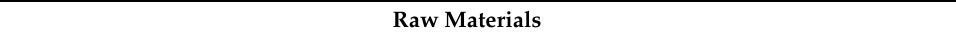
Table 8. Summary of the amounts of reagents, raw materials and sub-products involved in the industrial process (1000 kg of electrolytic manganese,